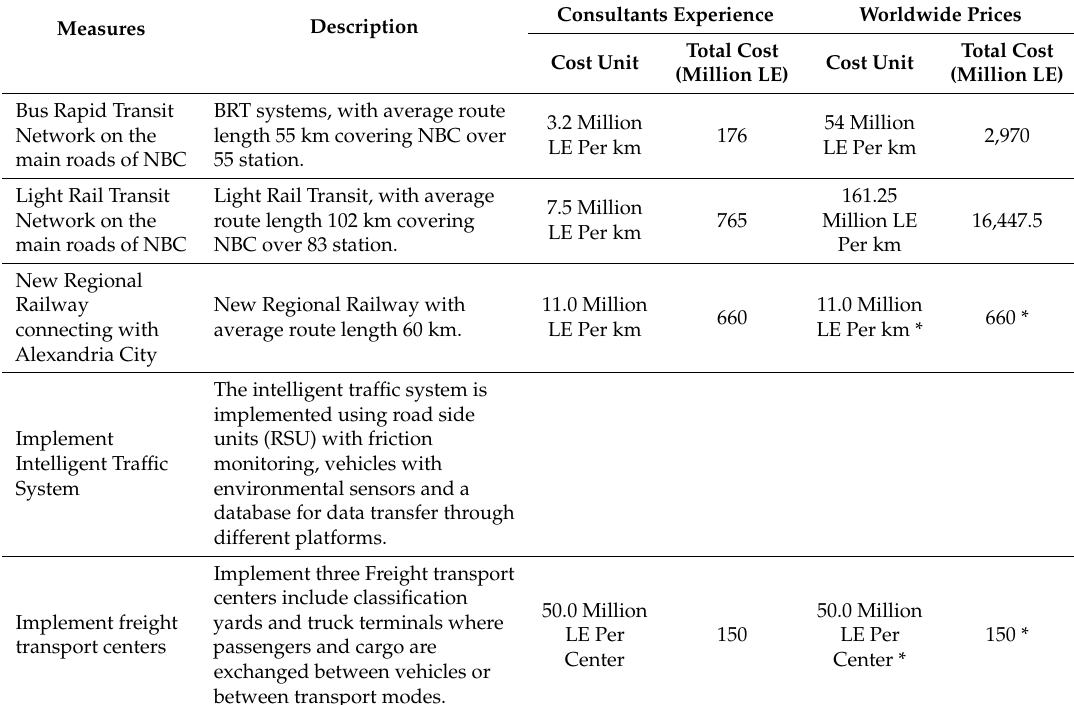
Table 6. High Investment Sustainability scenario costs